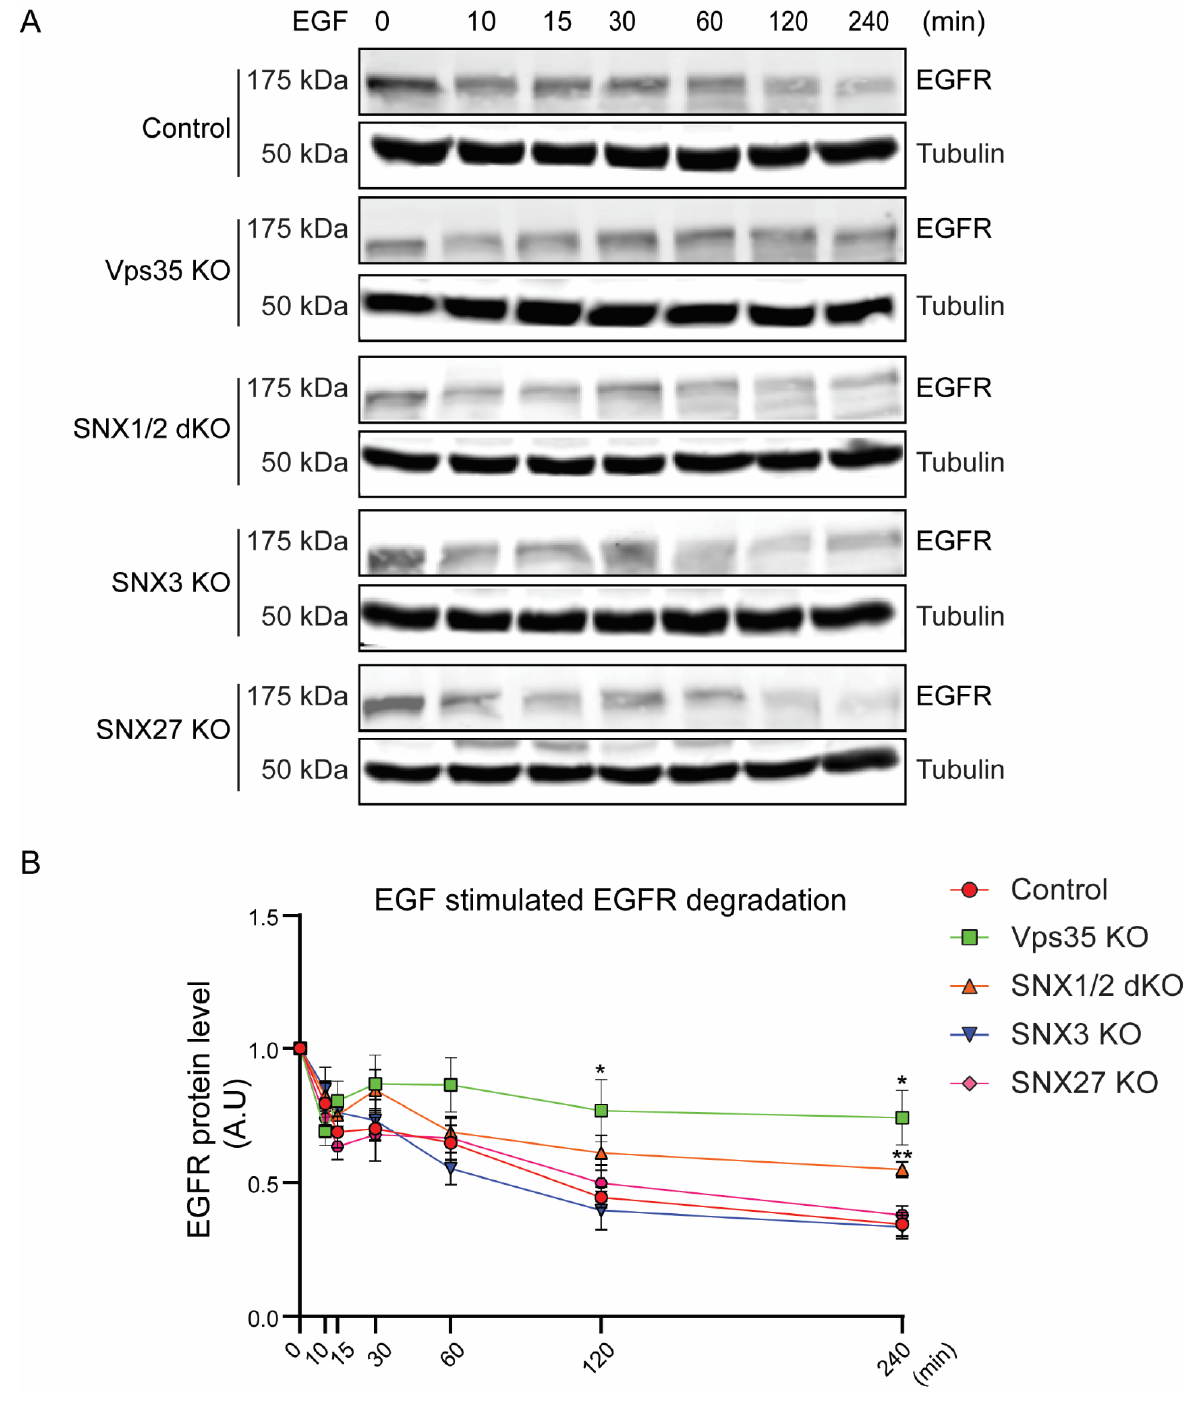
Figure 3. Retromer Vps35 or SNX1/2 depletion altered EGF-stimulated EGFR degradation. ( A ) Serum-starved cells were treated with 100 ug/mL of EGF for different time points. At indicated time points, cells were harvested, and equal amounts of protein samples were used for immunoblotting with EGFR antibody. Representative blots from at least three independent experiments are shown. ( B ) EGFR levels at each time point were normalized to the EGFR level at 0 min for each cell line. Graph represents the difference of EGFR levels during EGF stimulation (means ± SEM). Two-tailed student’s t -test indicated the difference, * p < 0.05, HeLa control vs. Vps35 KO (120 min); * p < 0.05, HeLa control vs. Vps35 KO (240 min); ** p < 0.01, HeLa control vs. SNX1/2 dKO (240